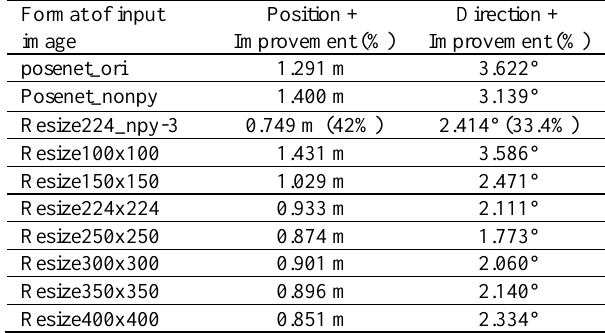
Figure 5. The loss convergence. Table 1. Median error results on underground parking